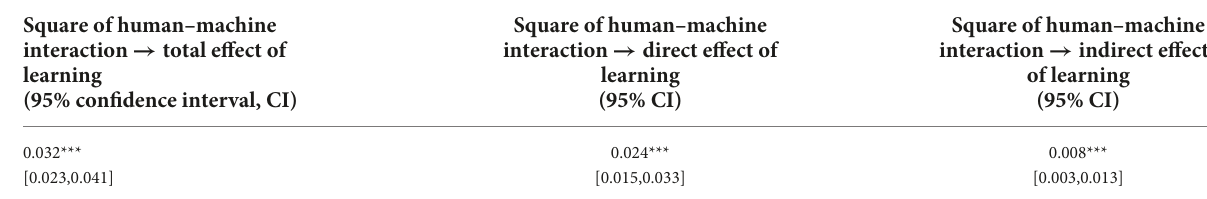
TABLE 6 Tests for mediating effects of